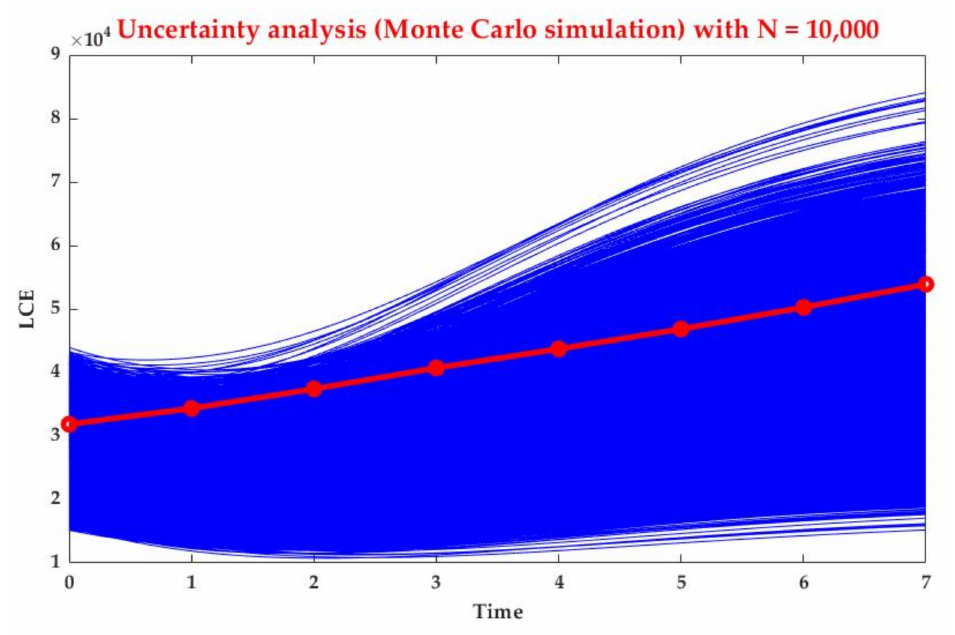
Figure 9. Electric vehicle production uncertainty vs. the reported demand from Macquarie [31] from 2019 to 2025.